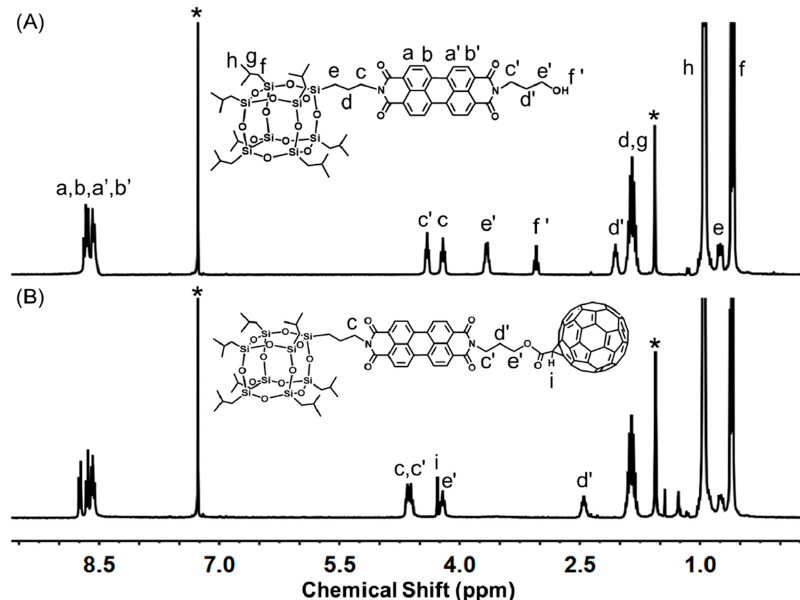
Figure 1. 1 H NMR spectra of ( A ) BPOSS-PDI-OH and ( B ) BPOSS-PDI-C 60 and the corresponding assignments. Asterisks denote signals from trace residual CHCl 3 or H 2 O.